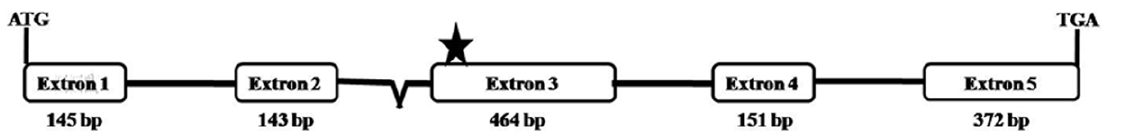
Figure 3. Schematic diagram of the TaRPK1-2G gene and its alternative splicing feature. Exons are shown as boxes. Introns are shown as black lines. The alternative splicing site is shown as diagonal lines. The star represents the premature stop codons in the alternative transcript.